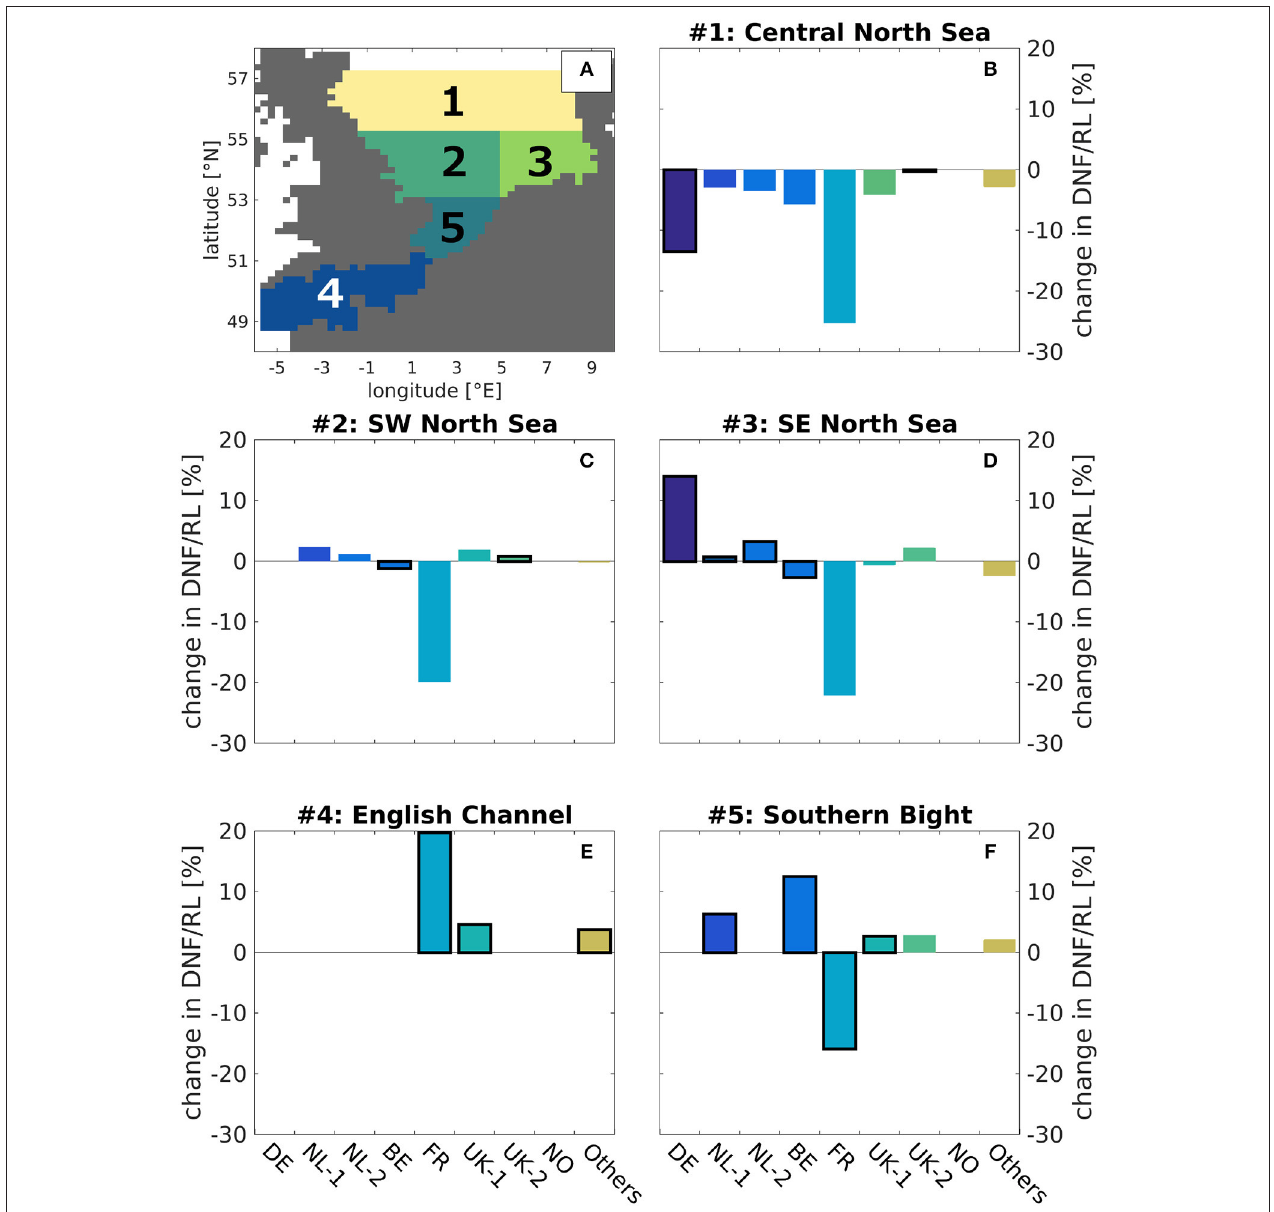
FIGURE 5 | Relative change in source-specific benthic denitrification per source-specific TN river load (“DNF/RL”) between reference simulation (“REF”) and WFD reduction scenario (“WFD”) in different sub-regions of the North Sea. (A) Selected North Sea sub-regions, (B–F) relative changes in the individual sub-regions calculated as (“WFD” − “REF”)/“REF” based on the 2006–2014 average DNF/RL of the two simulations. Values with DNF/RL < 0.01 in the reference simulation are not shown. Black-framed bars indicate DNF/RL ≥ 0.1 in the reference simulation.